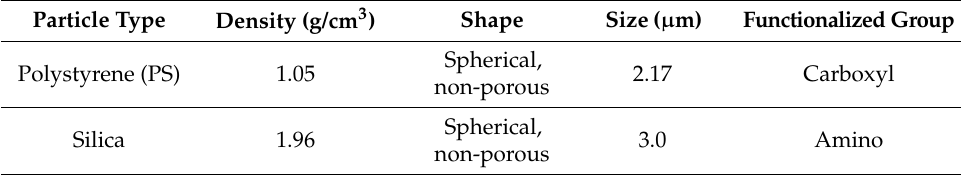
Table 1. Characteristics of polystyrene (PS) and silica microparticles used. Particle